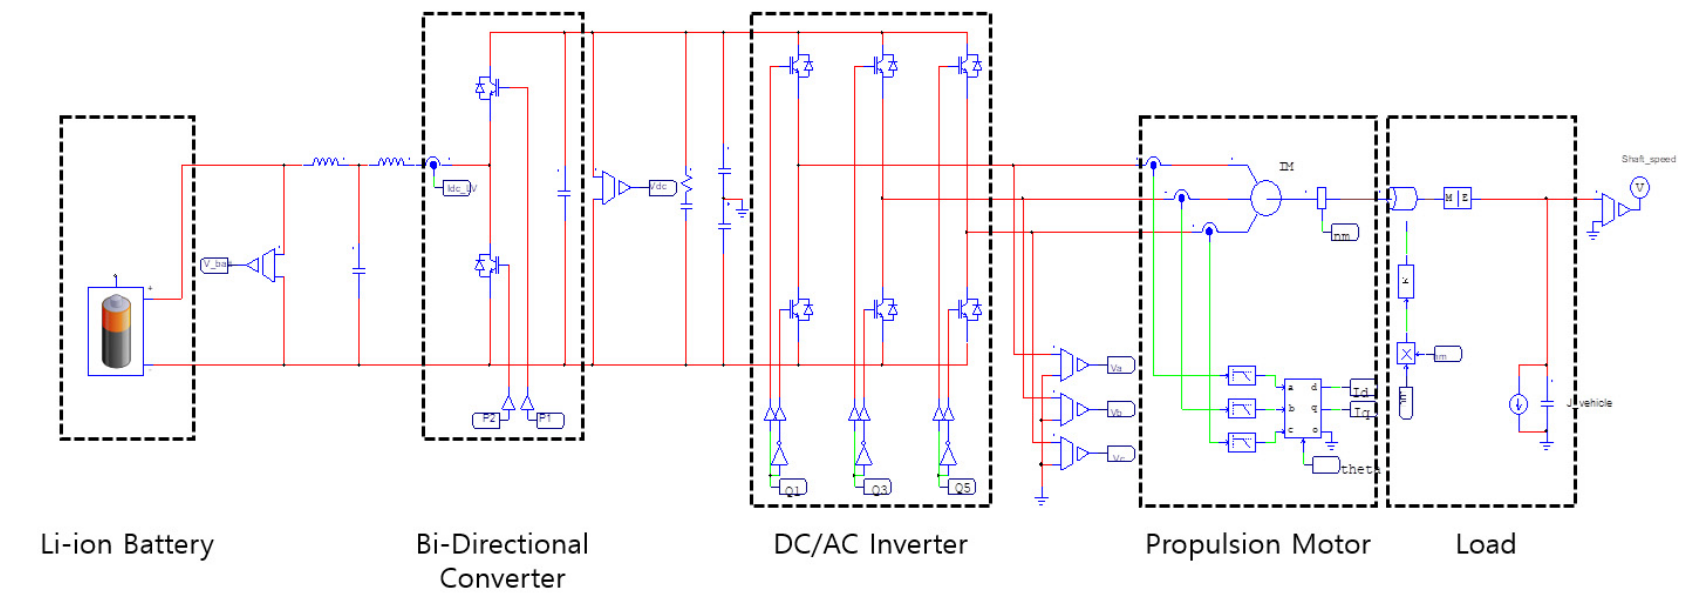
Figure A1. Modelling for battery propulsion system.